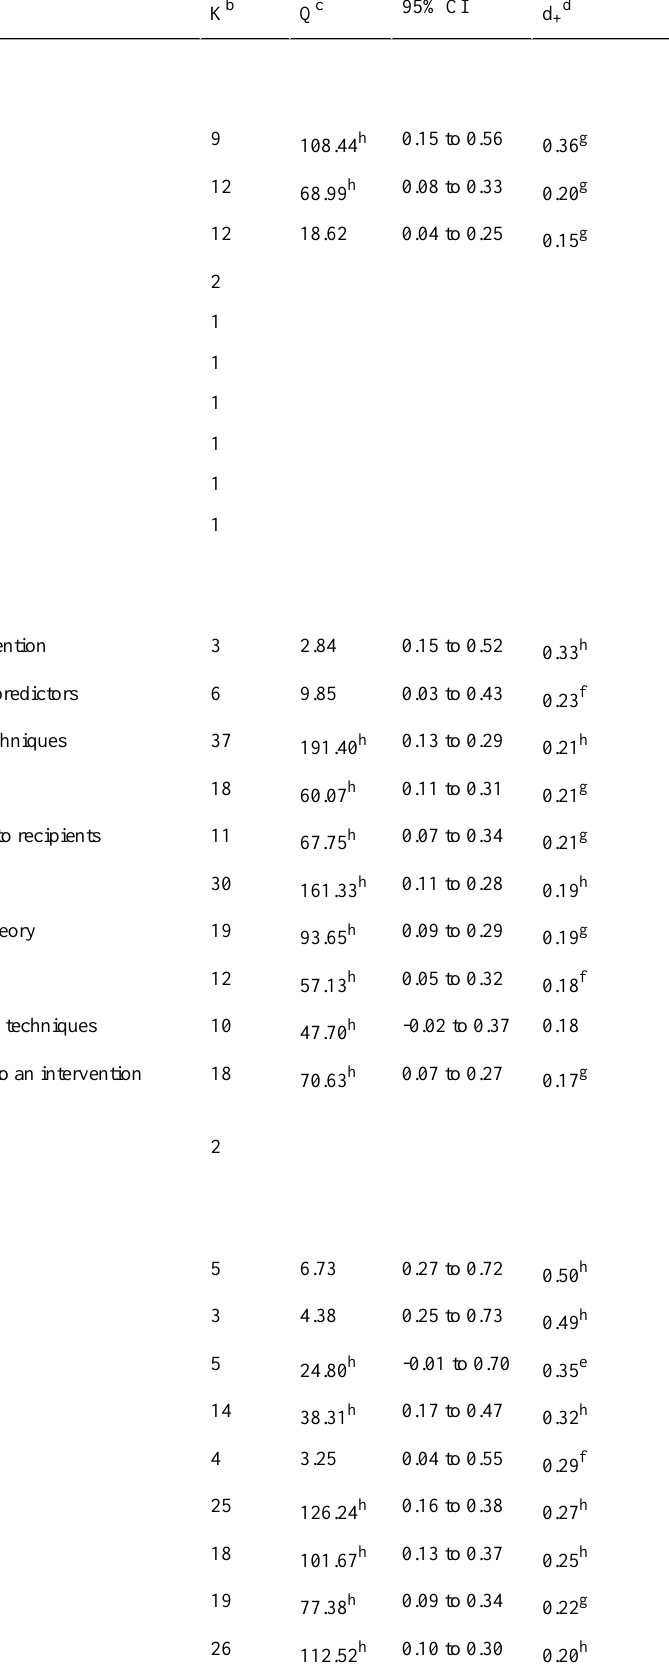
Table 2. Effect sizes a by theoretical basis, use of theory, behavior change techniques, and mode of delivery. The numbering for use of theory, behaviour change techniques, and the letters for mode of delivery correspond with those items in the coding frames and Multimedia Appendix